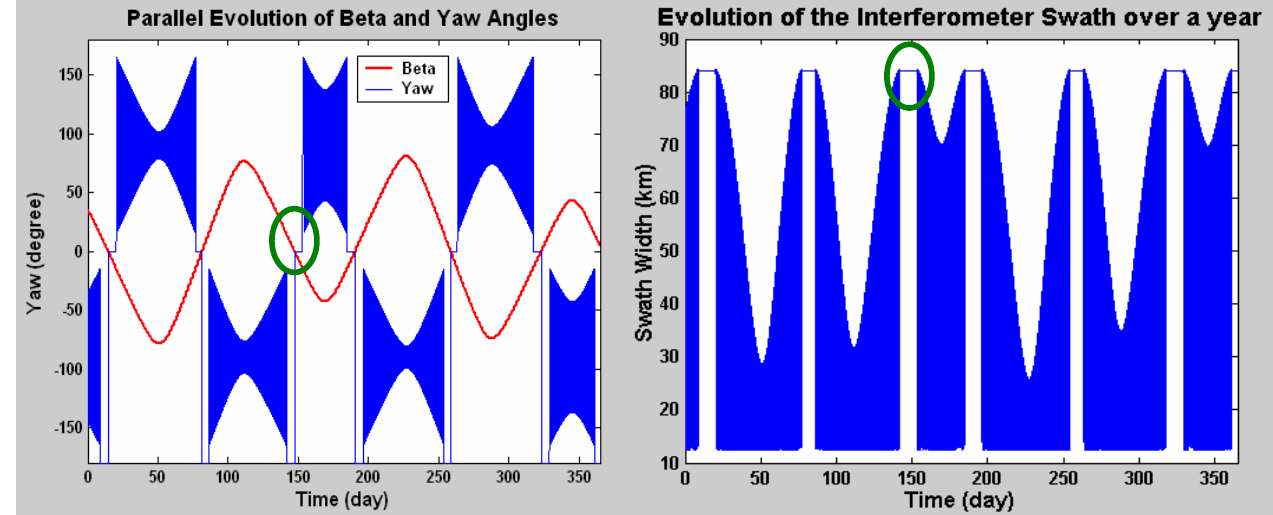
Figure 8. (a) Yaw steering onboard Jason-2 over a year (b) WSOA Swath Width over a year. Note the yaw and swath width vary between the minimum and maximum of their envelope within each orbital